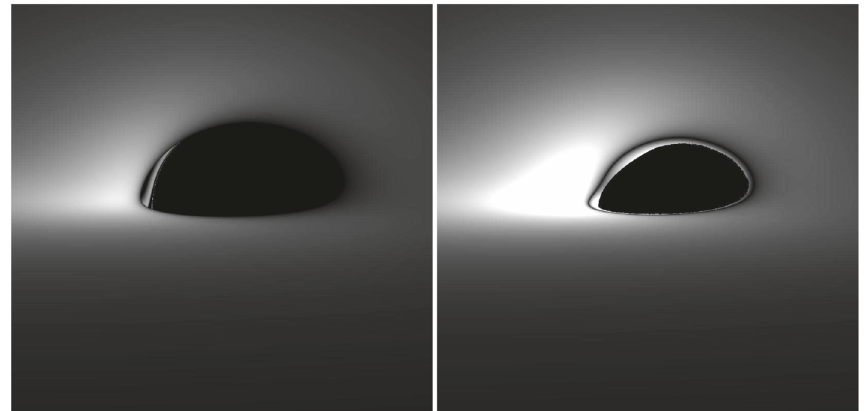
Figure 3: Infinite, counterclockwise rotating geometrically thin accretion disc around static and rotating compact objects viewed from an inclination of 80 ∘ . The left panel shows the disc model by [32] in pc-Gr, with 𝑎 = 0 . The right panel shows the modified model, including pc-GR correction terms as described in the